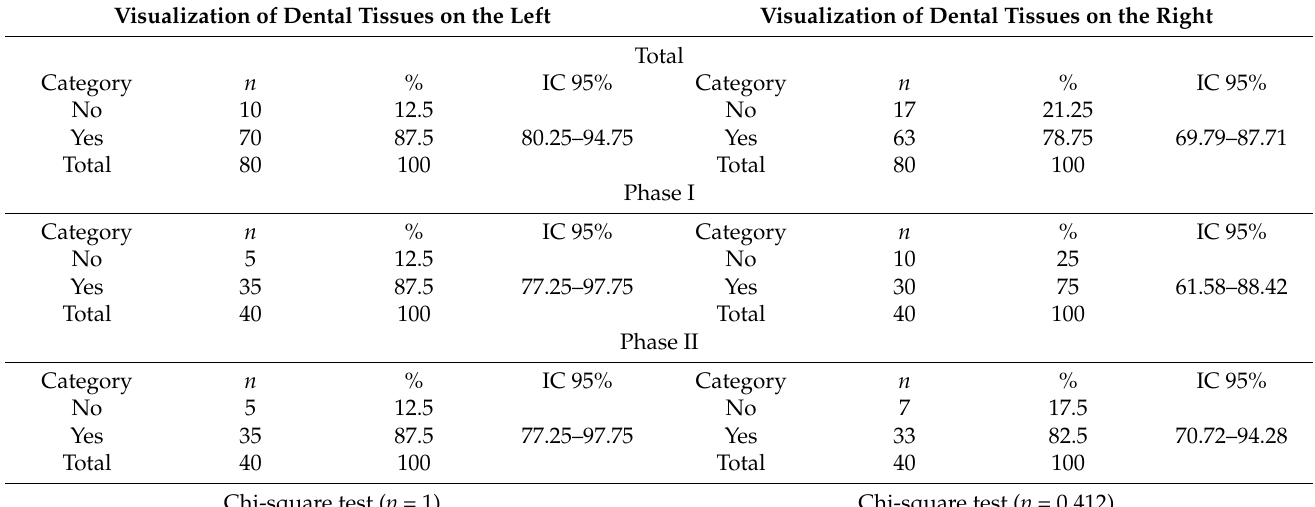
Table 2. Comparison of tissue visualization on the left and right sides between phase I and phase II. Visualization of Dental Tissues on the Left Visualization of Dental Tissues on the Right